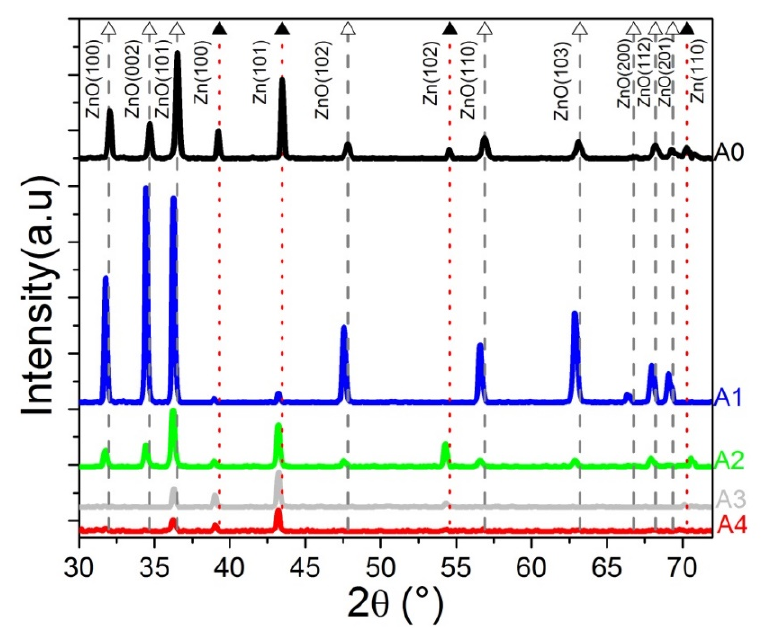
Figure 2. XRD diffraction patterns. All the samples were deposited by HFCVD for 1 min using a solid source. The source of the A0 sample was ZnO without NiO. The deposit temperatures of the ZnO:Ni samples (source of ZnO with NiO 1:1) were 500 °C, 400 °C, 350 °C, and 300 °C labeled as A1, A2, A3, and A4, respectively. The diffraction peaks shift to the left, taking A0 as a reference. The peak shift is attributed to Ni atoms incorporated in the ZnO lattice. Table 2. Calculated lattice parameters. The lattice parameters a and c were calculated using the Equation (1) and the XRD peaks at 31.85 ◦ (100) and 34.45 ◦ (002) for ZnO, and at 36.34 ◦ (002) and 39.31 ◦ (100) for Zn. The effect is due to the change in the deposit temperature.